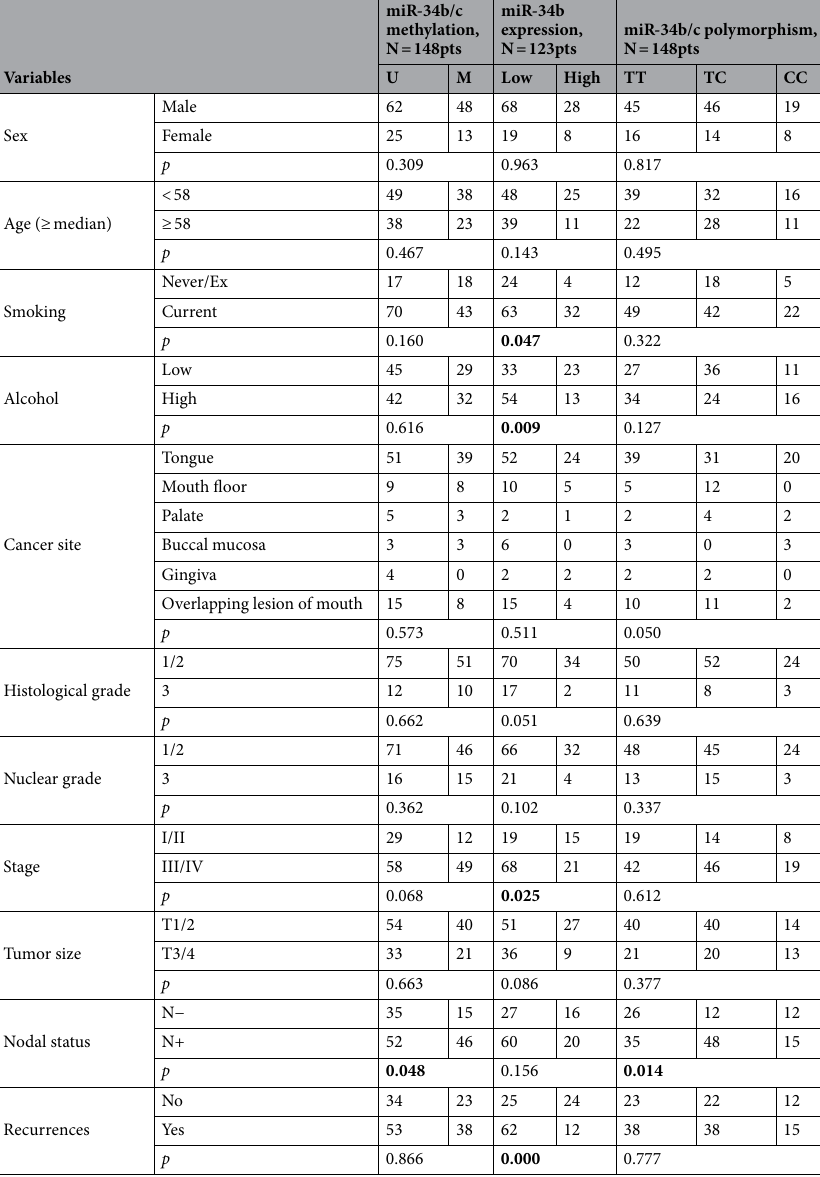
Table 1. Association of miR-34b/c promoter methylation, gene expression and rs4938723 polymorphism with demographic and clinico-pathohistological features of OSCC patients. U Unmethylated, M methylated. miRNAs High/Low expression defined according to cutoff (3.58) derived from ROC analysis. Significant values, p < 0.05, are